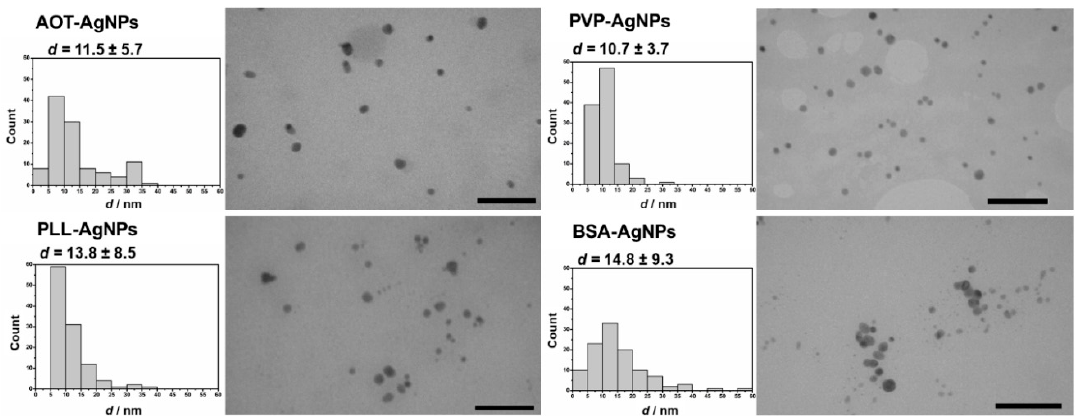
Figure 1. Transmission electron micrographs (TEM) show shape of different AgNPs coated with AOT, PVP, PLL and BSA dispersed in ultrapure water. Scale bars are in 100 nm. Size histograms and primary sizes ( d , nm) of each AgNPs were obtained from the cross-sectional area of the particles as described in Supplementary Information.